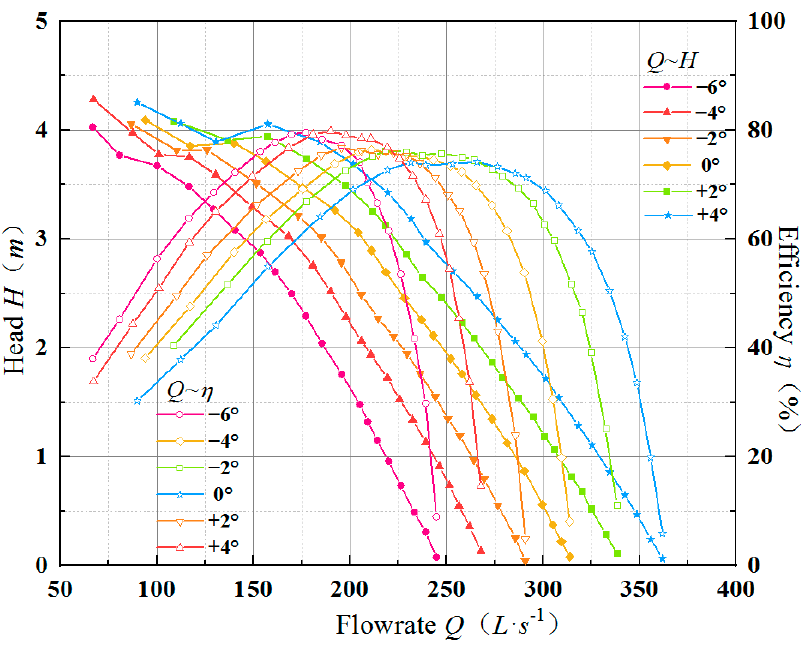
Figure 7. Comprehensive characteristic curve of the pump under different blade angles. Table 3. Optimal efficiency point parameters of the pump under different blade angles.